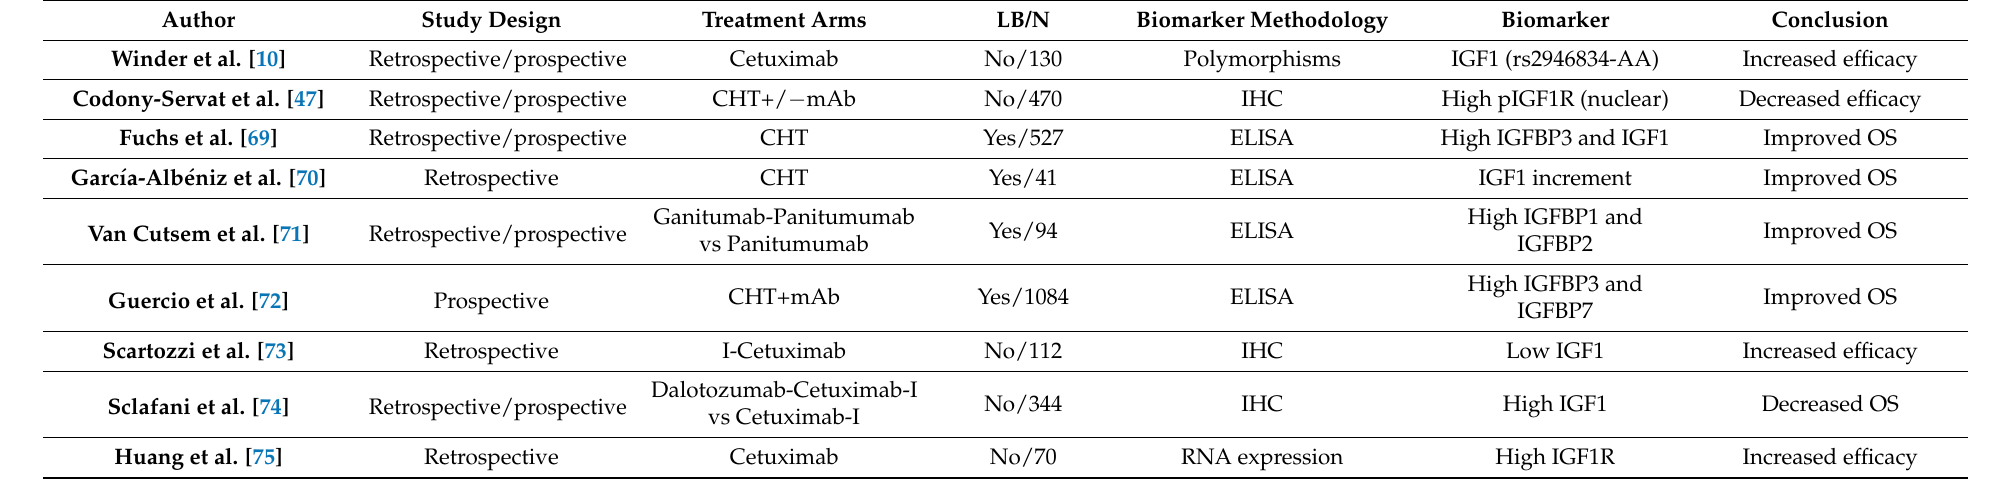
Table 1. IGF1R pathway biomarkers in metastatic colorectal